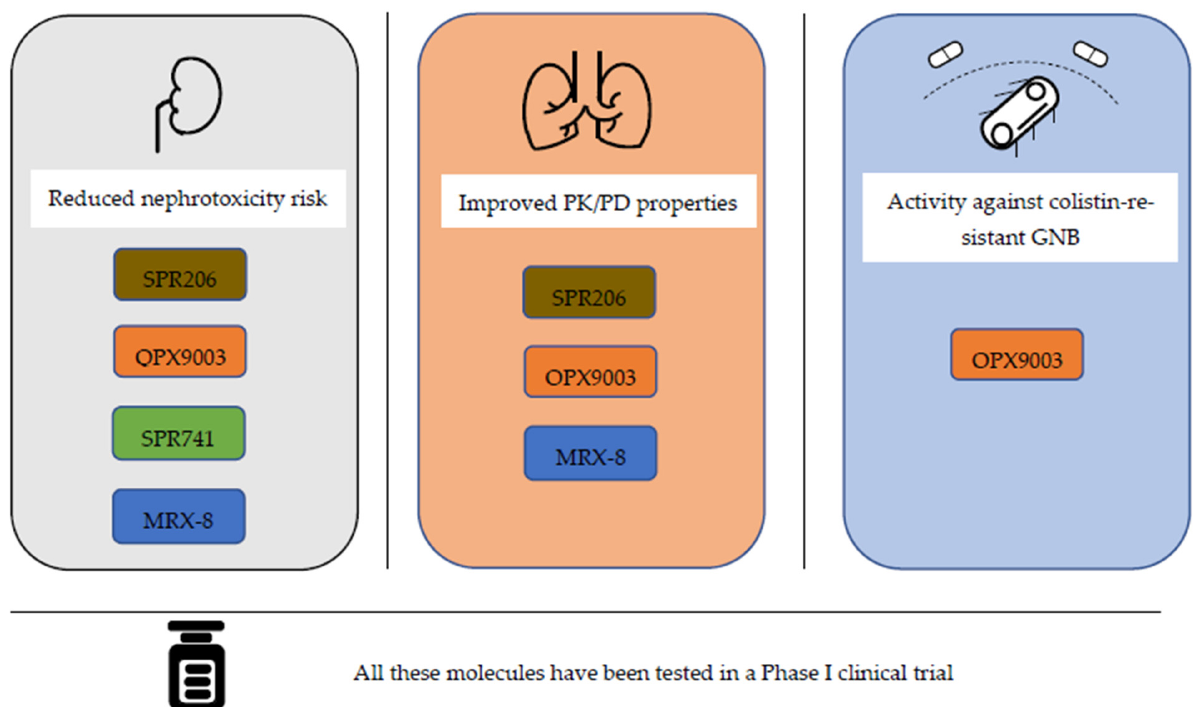
Figure 1. Chemical structure of polymyxin B and colistin. Amino acid residue differing between polymyxin B and colistin at R6 position: D -Phe for polymyxin B and D -Leu for colistin. Abbreviations: Dab, diaminobutyric acid; Thr, threonine; Phe, phenylalanine; Leu, leucine.